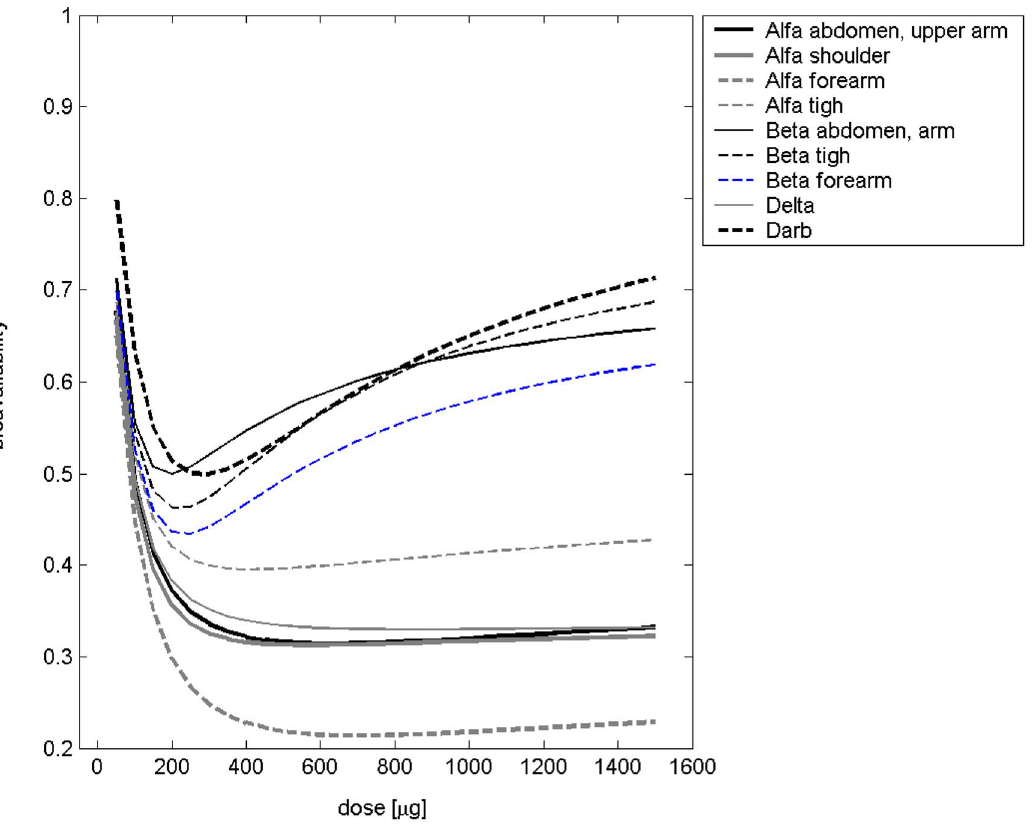
Figure 6. Estimated bioavailability of erythropoietin after different types of injection and in dependence on dose. Here, bioavailability is defined as the ratio of the integrated influxes into the central compartment under subcutaneous and intravenous injection respectively.